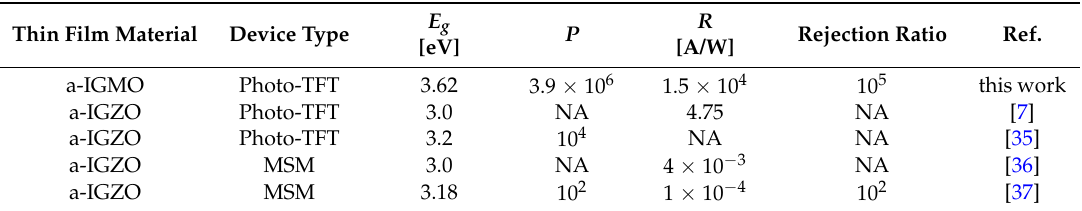
Figure 7. ( a ) Transfer characteristics vs. wavelength; ( b ) spectral response characteristics of the 240-min annealed a-IGMO photo-TFT. Table 2. Comparison of the device performance of the present a-IGMO UV photo-TFT and some reported a-IGZO UV photodetectors.